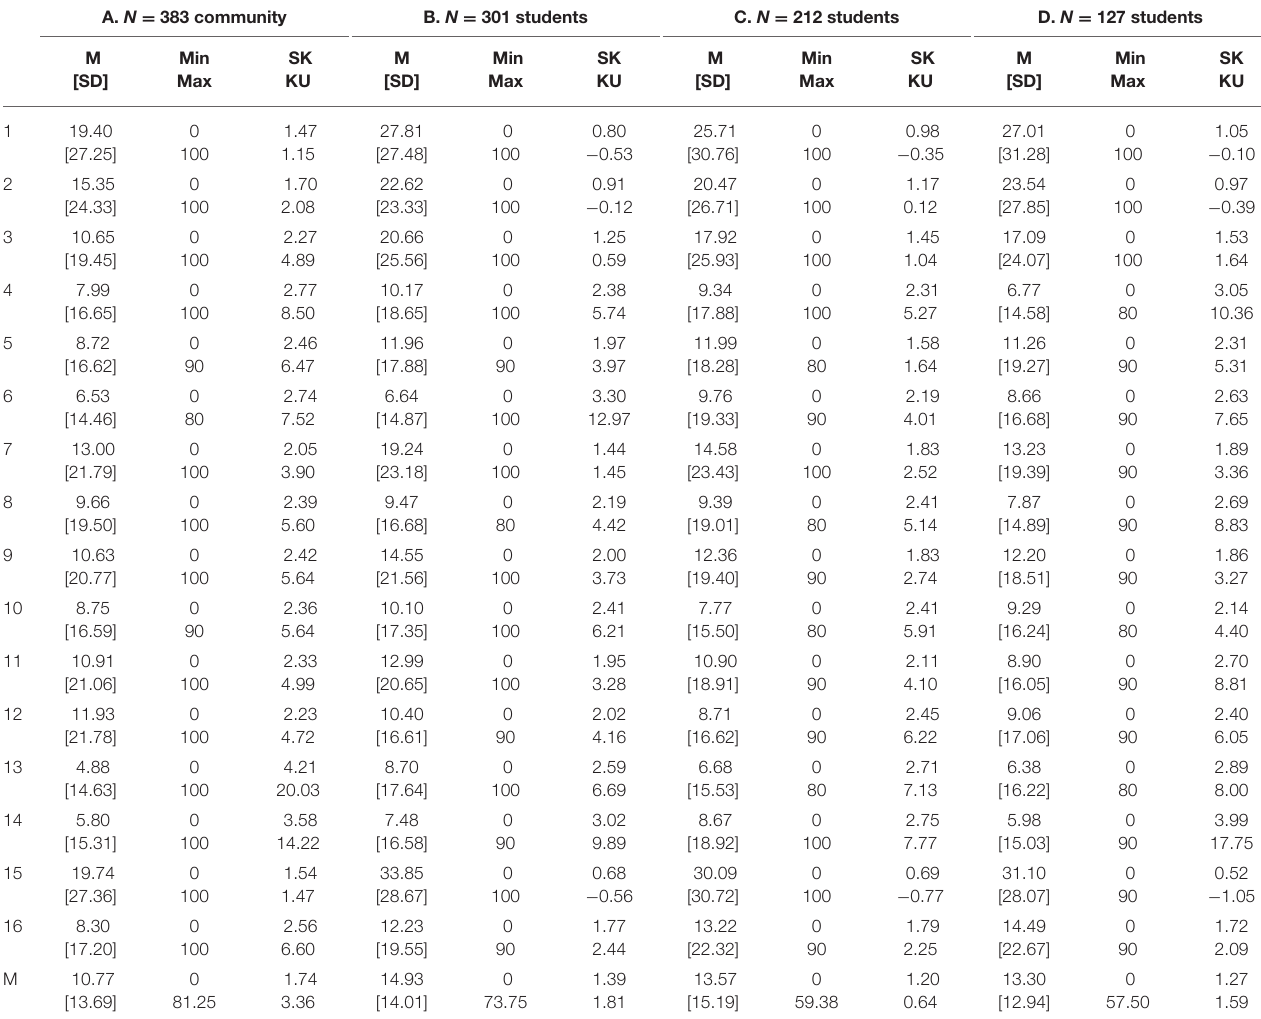
M, Mean; SD, Standard Deviation; SK, Skewness; KU, Kurtosis. Rows represent items of the MDS-16. For each item, the parameters represented are mean and standard deviation (left), minimum and maximum (middle), and skewness and kurtosis (right). The bottom row depicts descriptive statistics for respondents’ mean MDS-16